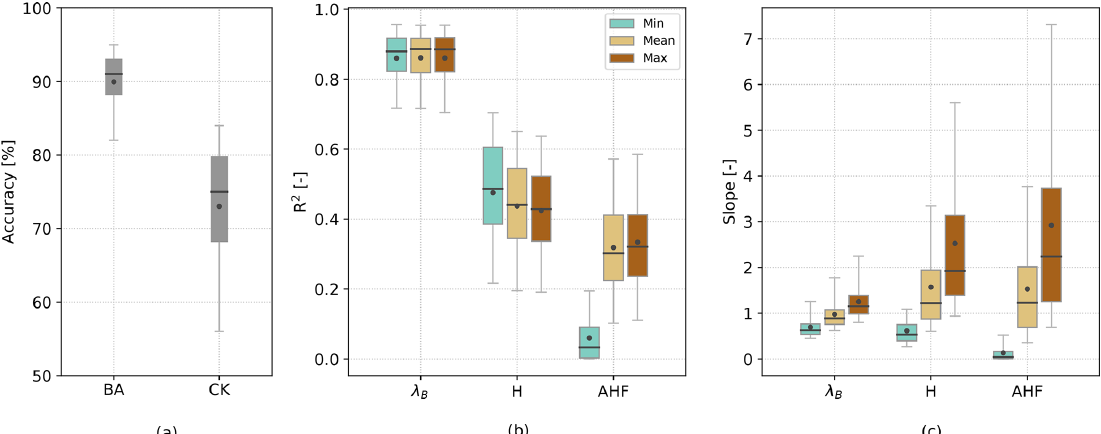
Figure 10. Results for the thematic benchmark, for the urban mask from the Copernicus Global Land Cover Layers (a) and the building surface fraction, building height, and anthropogenic heat flux ( λ B , H , and AHF respectively) (b, c) . All accuracies are derived for the 150 global LCZ functional urban areas. For built-up land, accuracy is expressed using the balanced accuracy (BA) and Cohen’s kappa (CK). For λ B , H , and AHF, the coefficients of determination ( R 2 ) (b) and slopes (c) result from the regression between the reference datasets and their corresponding universal LCZ-based values from Stewart and Oke (2012), using minimum (Min), mean, and maximum (Max) values (colours). For all panels, boxes and whiskers span the 25th–75th and 5th–95th percentiles respectively. The means and medians are indicated by the black dots and lines respectively. Results stratified per urban ecoregion are available in Appendix